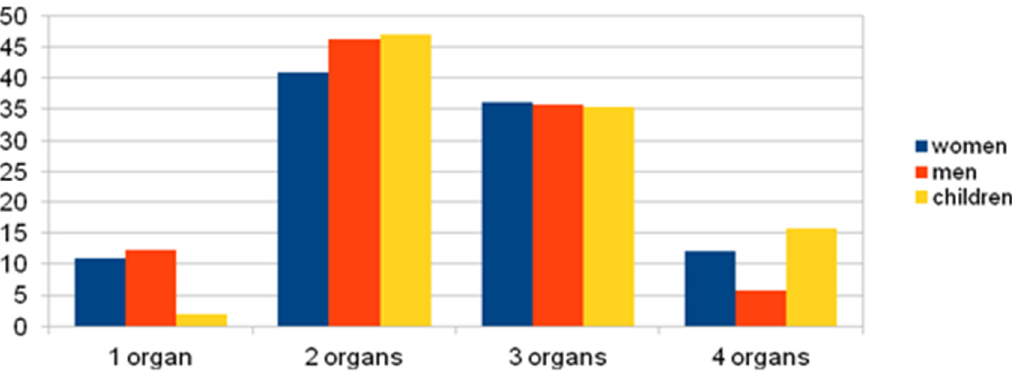
Figure 5. % of Cases anaphylaxis with 1, 2, 3 or 4 affected organ systems with groups divided into women, men, and children.